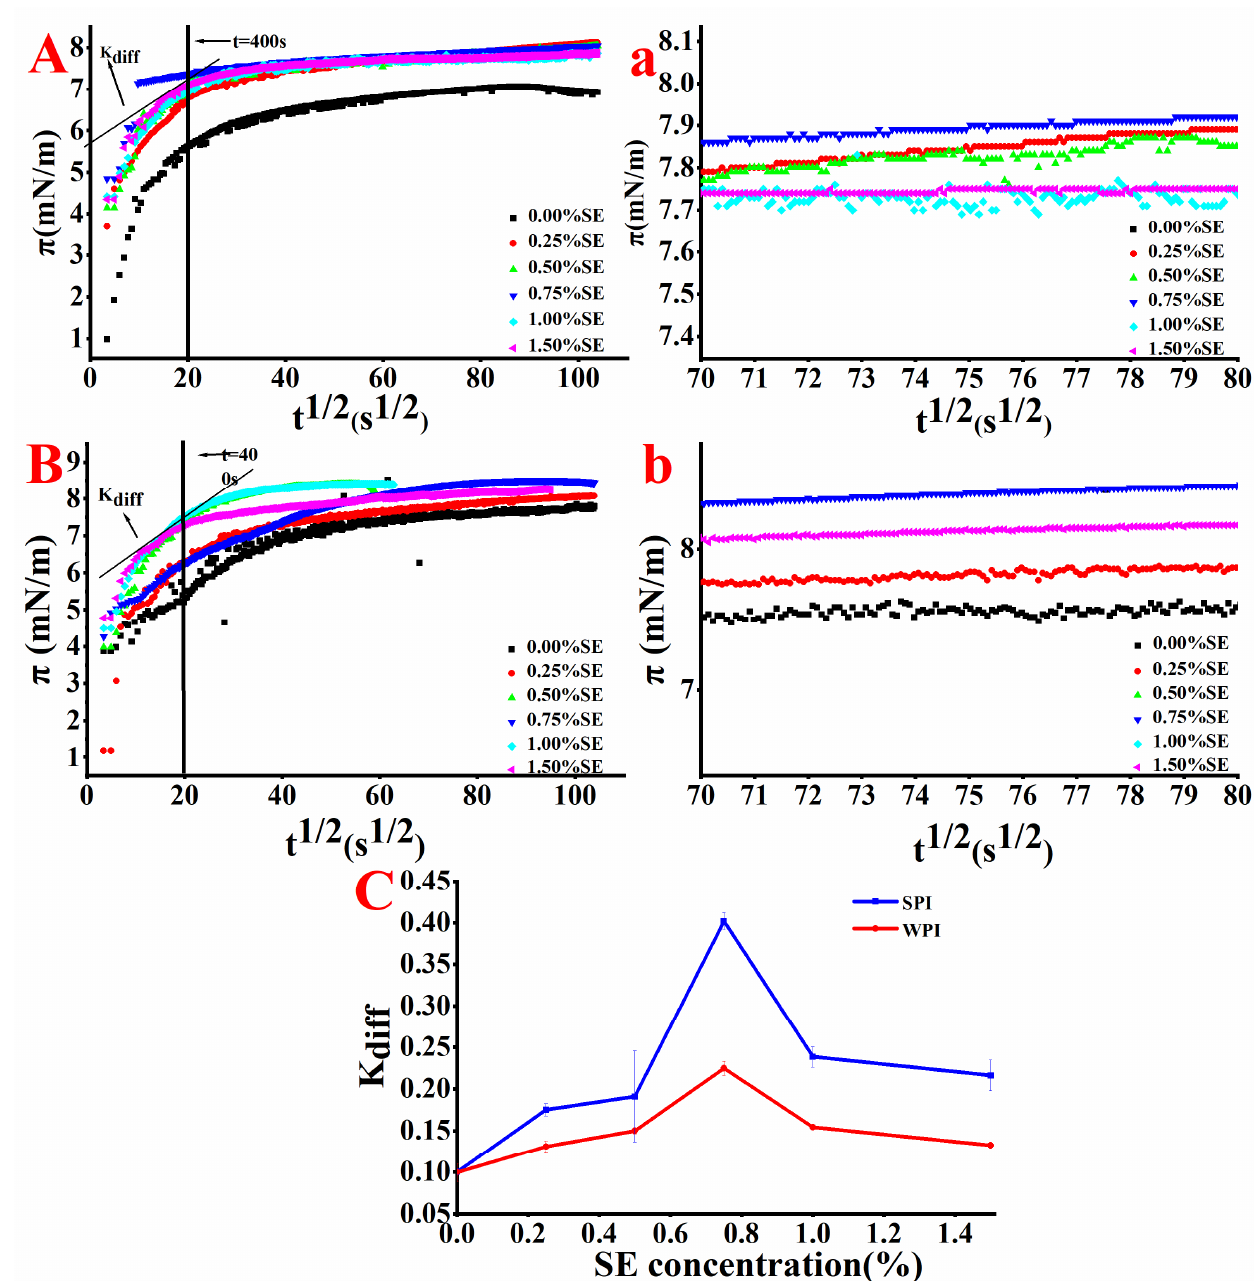
Figure 2. The curve of surface pressure ( π ) of oil-water interface of the emulsions with time square root (t 1/2 ) (( A ): SPI; ( B ): WPI); Figure ( a ) is partial enlarged view of Figure ( A ) at 70–80 s 1/2 . Figure ( b ) is partial enlarged view of Figure ( B ) at 70–80 s 1/2 . K diff of emulsions at different SE concentrations ( C ).